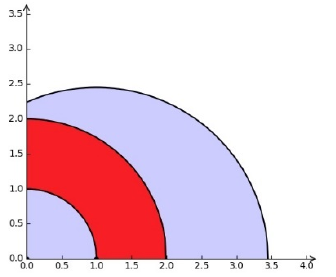
Figure 5. The mixture of Figures 3 and 4.